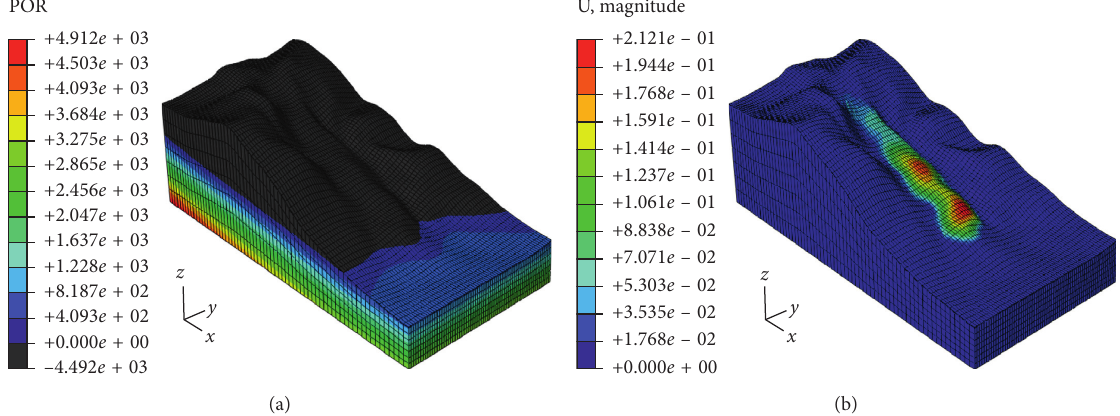
Figure 6: Distribution of stress field under condition 1. (a) Maximum principal stress field. (b) Minimum principal stress